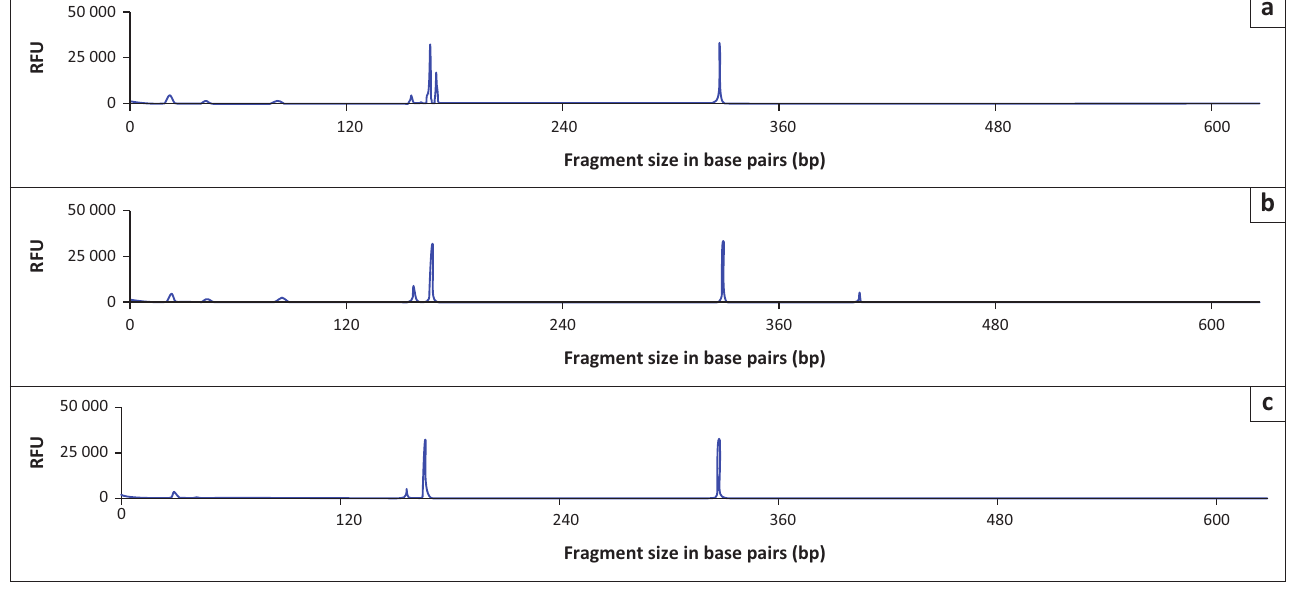
Figure 1 : Observed capillary electropherograms of the NPM1 and FLT3 control samples (February 2020, Bloemfontein, Free State, South Africa). (a) NPM1 positive control with an additional amplicon at 174 base pairs representing the 4 base pairs insertion, and wild-type FLT3- ITD at 330 base pairs. (b) FLT3 -ITD positive control with an additional amplicon at 405 base pairs, representing the 75 base pairs internal tandem duplication and NPM1 wild-type at 170 base pairs. (c) NPM1 and FLT3 -ITD negative control with expected amplicons at 170 base pairs and 330 base